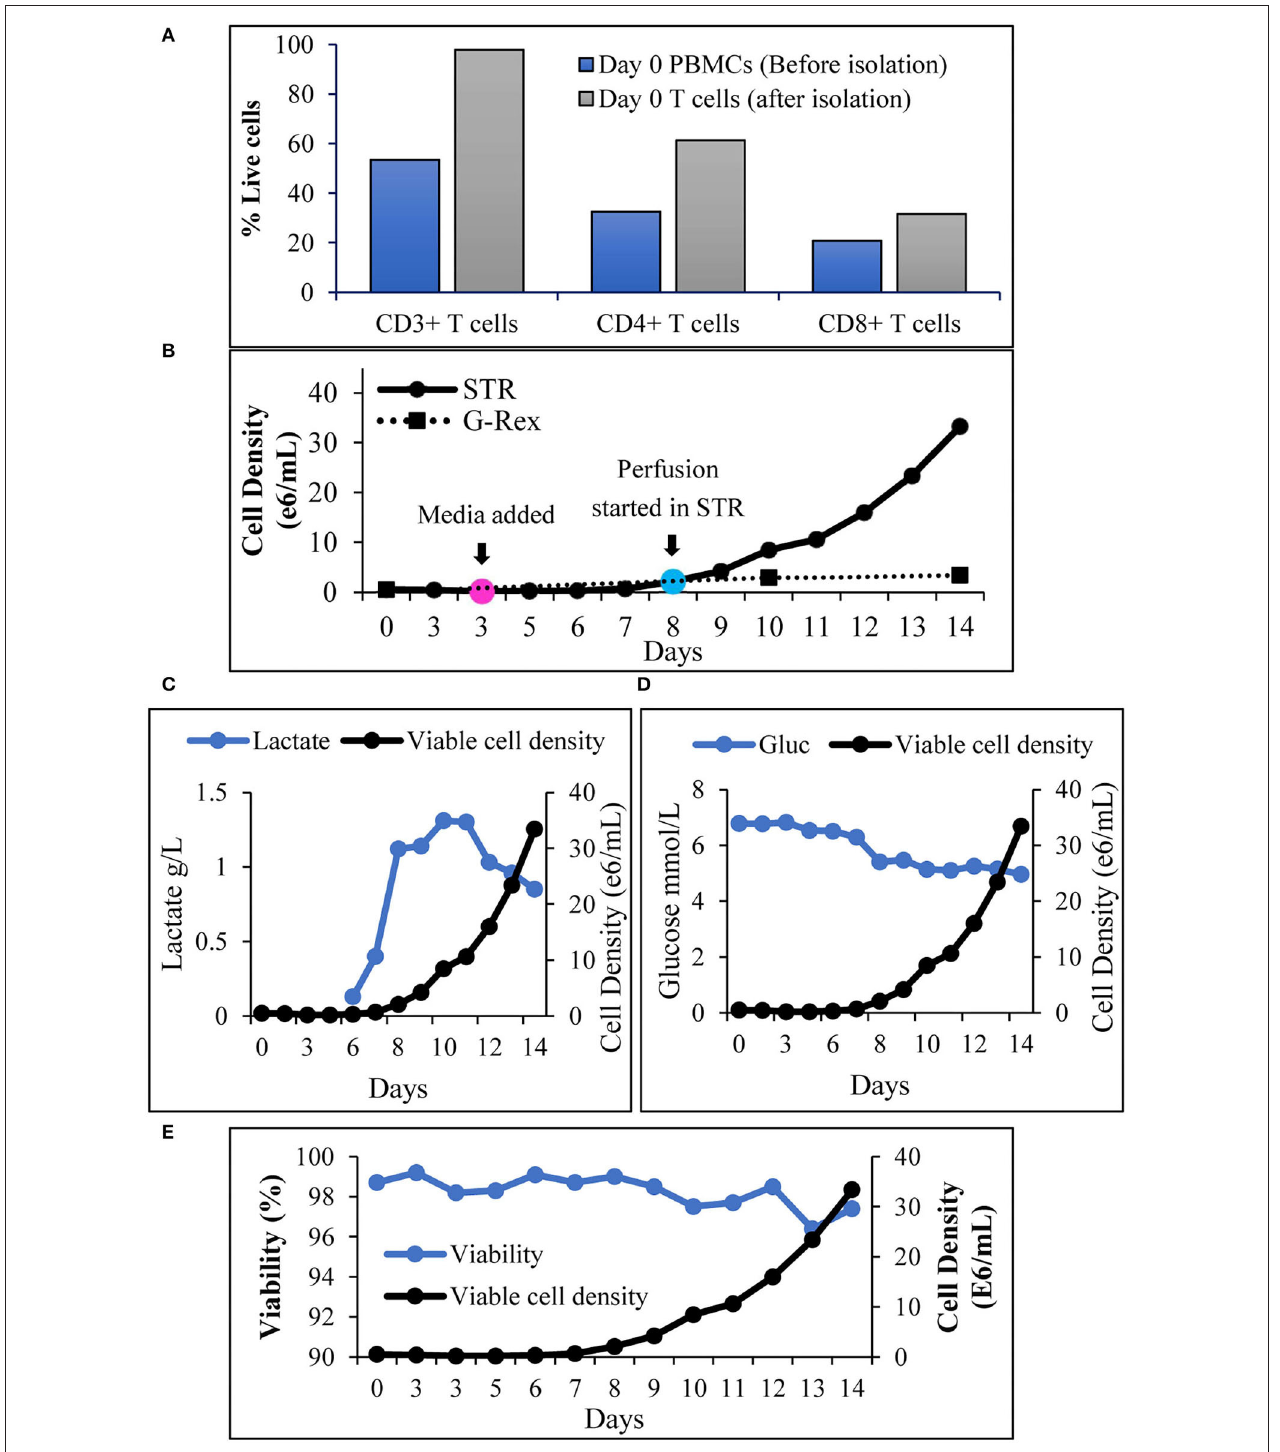
FIGURE 2 | Alternating tangential flow mediated continuous perfusion in stirred tank bioreactor enables T cell expansion: (A) Prominent subsets of T cells before and after isolation from PBMCs. The values represent an average of 50,000 single cells per condition; (B) Viable cell density of T cells during 14 days expansion. Cell count in STR was performed at inoculation (day 0), before and after media addition (Day 3) and then each day till day 14. Cell count in G-Rex® was performed on day 0 at inoculation, on days 10 and 14. The values represent mean ± S.E. of three technical replicates; (C) Lactate levels during 14 days of T cell cultivation in the stirred tank bioreactor in comparison to viable cell density; (D) Glucose levels during 14 days of T cell cultivation in the stirred tank bioreactor in comparison to viable cell density; (E) Cell viability of T cells during 14 days of T cell cultivation in the stirred tank bioreactor. The values represent mean ± S.E. of three technical replicates.